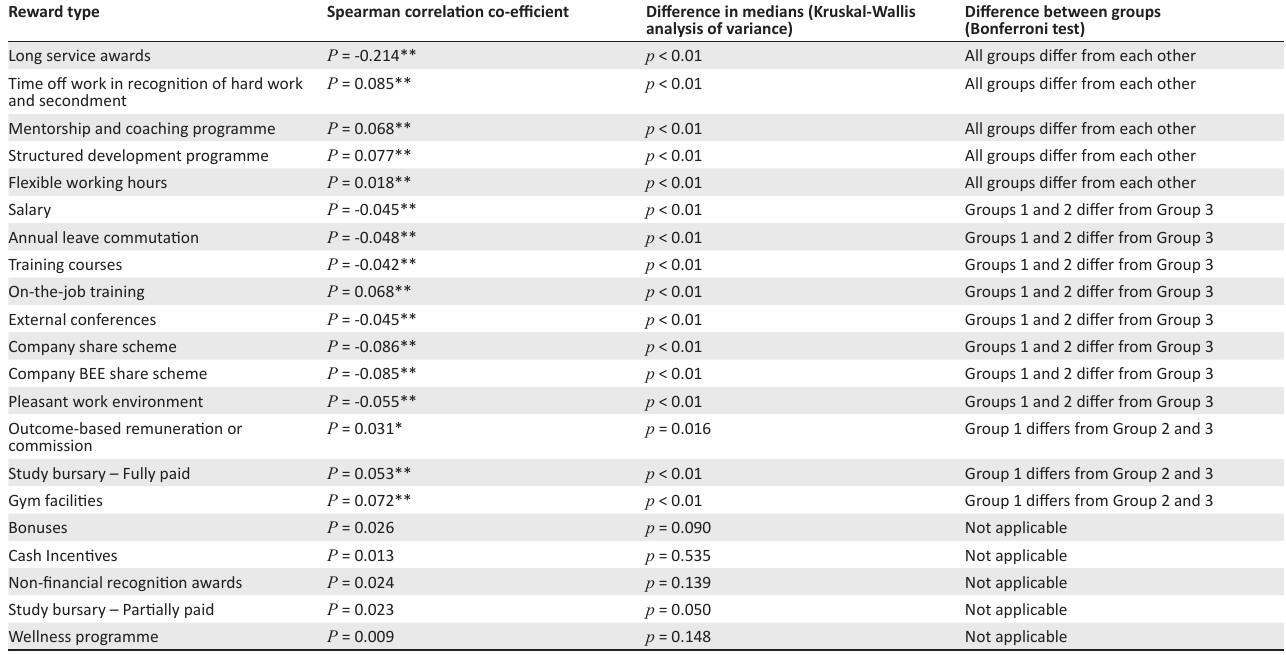
TABLE 4: The total reward package that was received by employees. Reward